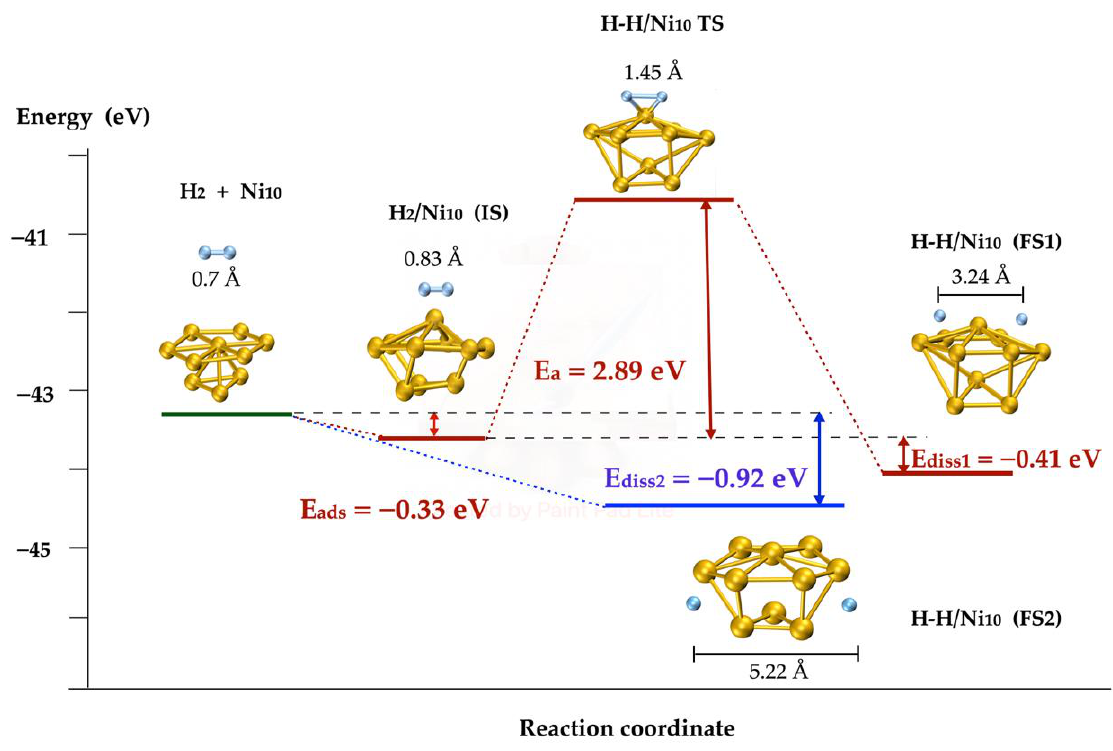
Figure 4. H 2 dissociation pathways on Ni 10 metallic cluster. The blue lines mark the spontaneous pathway and red lines correspond to the activated one. The blue spheres represent H atoms and yellow spheres are Ni atoms.